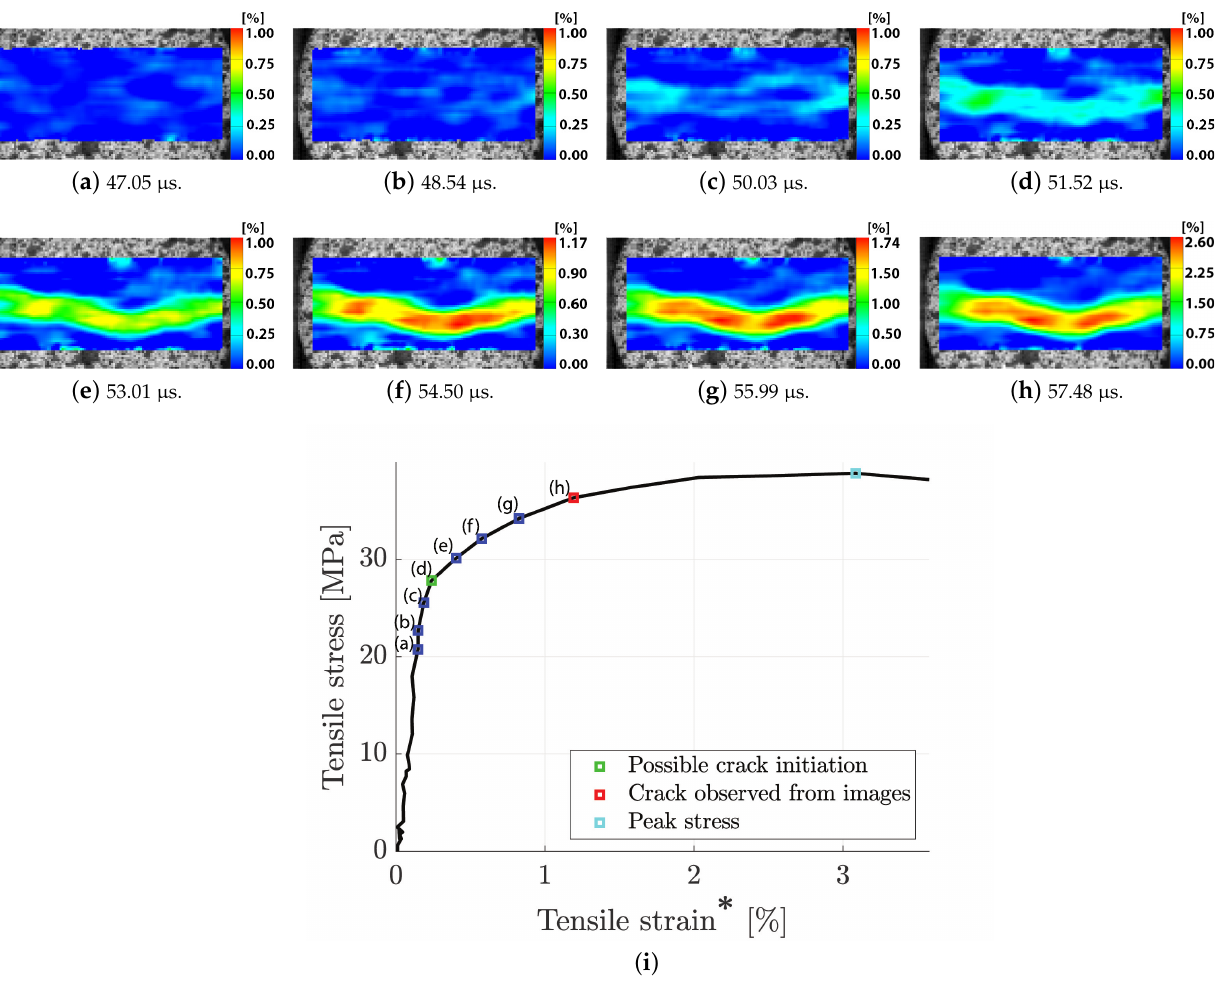
Figure 9. An example of high-speed photography and DIC of a Brazilian disc test of granite ( a – h ) together with the corresponding indirect tensile stress versus tensile strain ( i ). The ∗ denotes that the use of the term strain after crack initiation is dubious since the measurement is only valid up until the instant of crack initiation. Note that the use of the term strain after crack initiation is dubious since the measurement is only valid up until the instant of initiation. The resolution of the high-speed images ( a – h ) is 128 × 64 pixels or 26.0 × 13.0 mm.